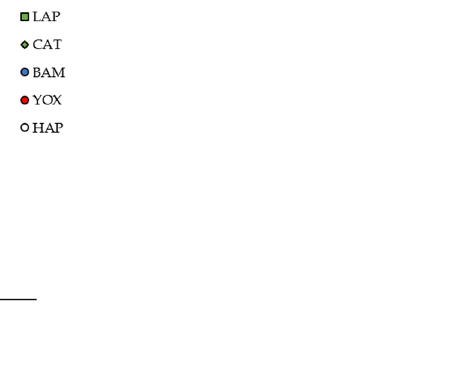
(cid:112) d 502 · χ and the removal efficiencies presented in